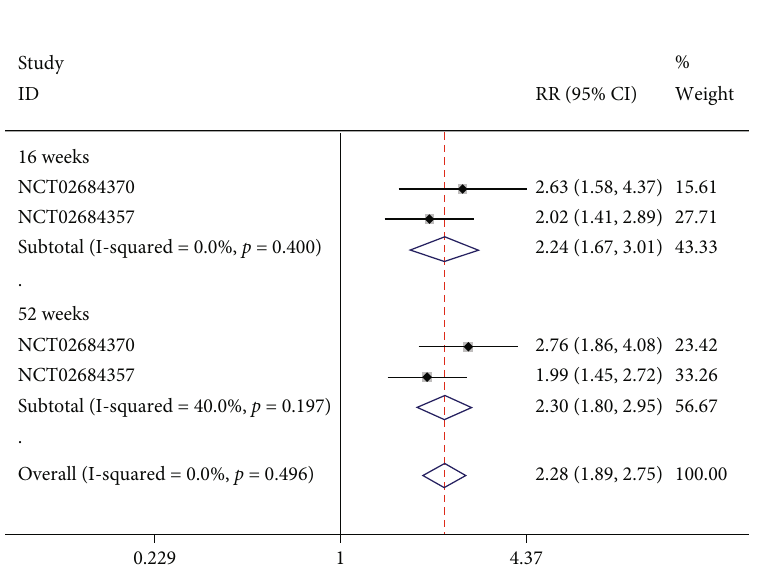
Figure 8: Forest plot of sPGA scores of